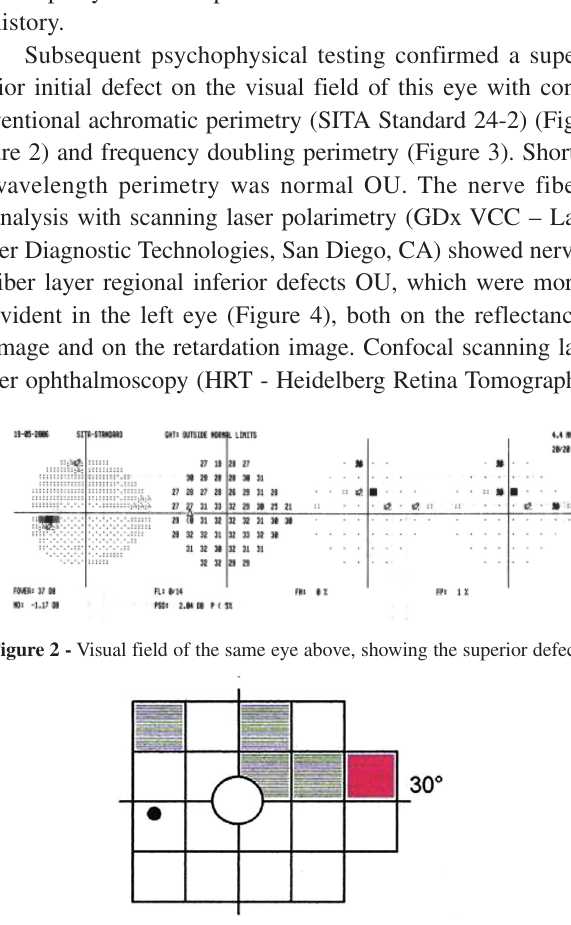
Figure 3 - Frequency doubling perimetry showing the superior defect